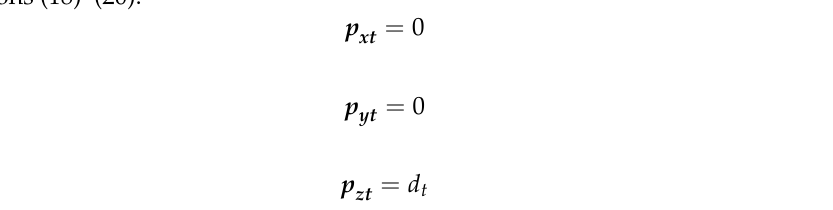
Figure 9. Fire-Extinguishing Ball-Shooting Turret Control System.